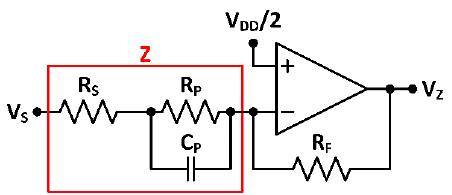
Figure 14. Test impedance with an auto-balancing bridge.